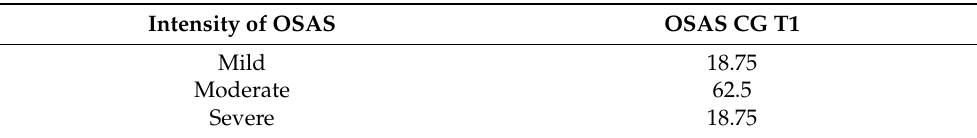
Table 6. Intensity of OSAS of the CG at